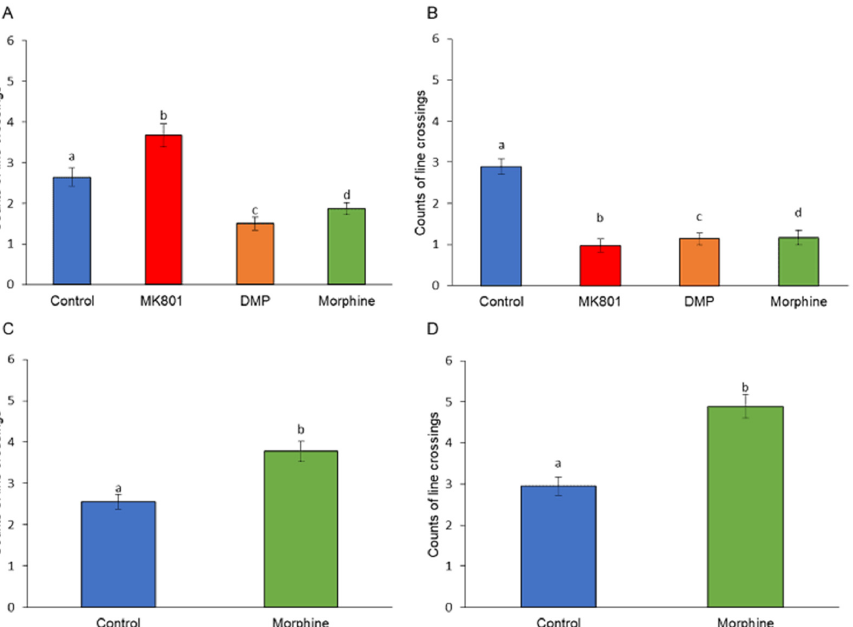
Figure 1. Effects of ( A ) short-term (F (3, 140) = 42.92, p = 0.01) and ( B ) long-term (F (3, 140) = 114.29, p = 0.00) exposure to MK801, DMP, and morphine, and after withdrawal of ( C ) short-term (t (70) = 35.30, p = 0.00) and ( D ) long-term (t (70) = 177.64, p = 0.00) morphine treatment on the locomotor activity. Data expressed as mean ± SEM, n = 12 of 3 independent experiments. Different alphabets indicate statistically significant values, p < 0.05. Drug abbreviation: DMP, domperidone.